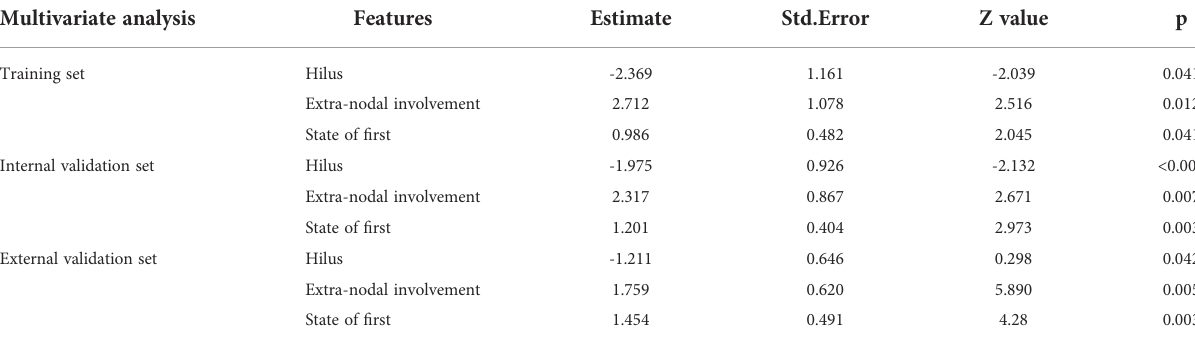
TABLE 3 Multivariate analysis of clinical and ultrasonic features. Multivariate